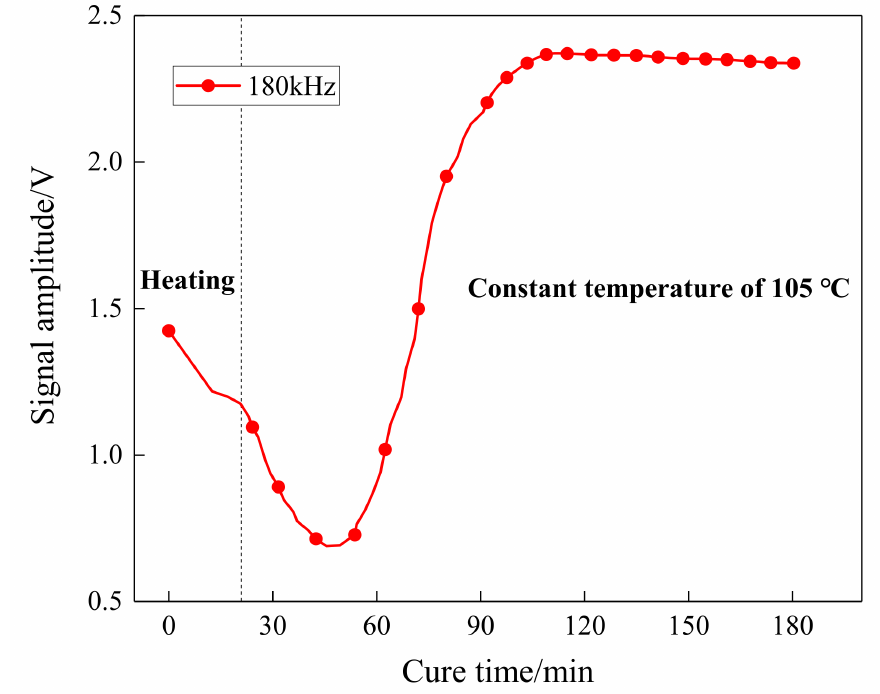
Figure 11. The amplitude variation of the sensing path P4s_6s over